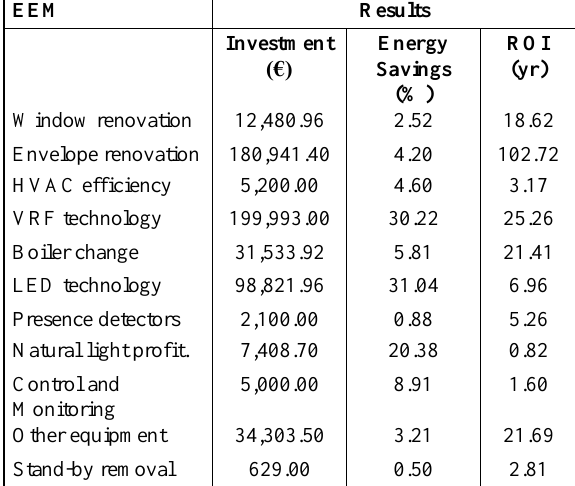
Table 2. Summary results of EEM in CIPFP Blasco